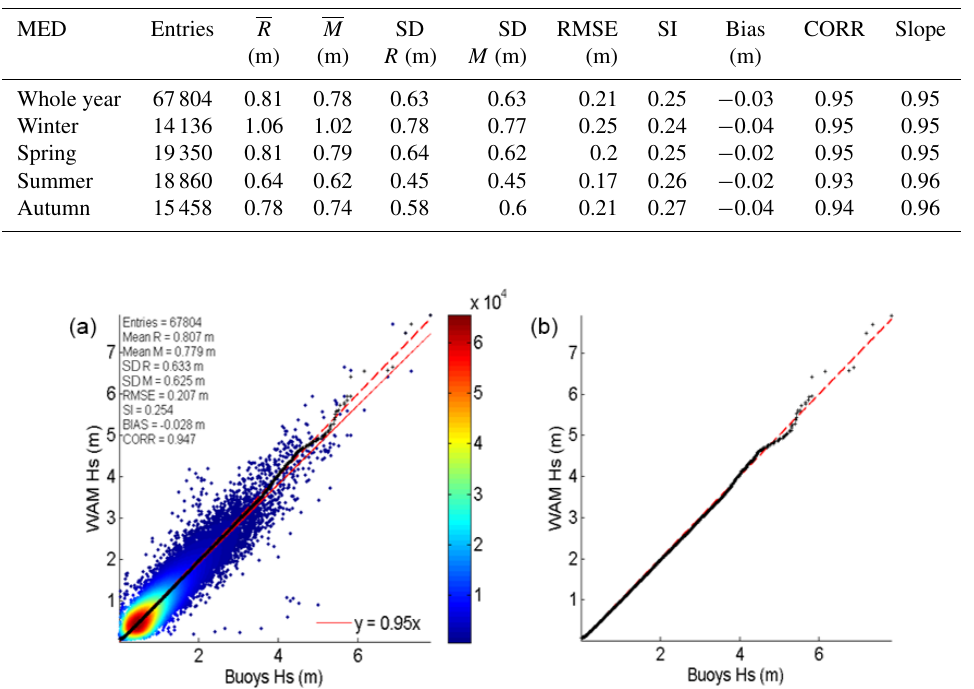
Table 1. Med-waves H s evaluation against wave buoy H s , for the full Mediterranean Sea, for a 1-year period (2014) and seasonally.